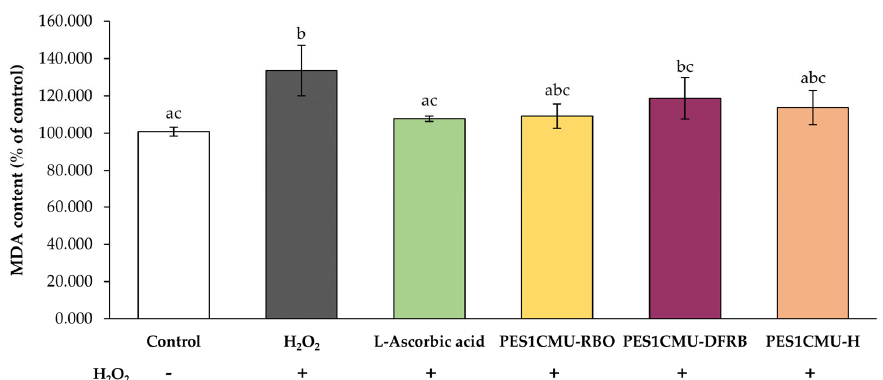
Figure 4. Effects of rice bran oil (PES1CMU − RBO), defatted rice bran extract (PES1CMU − DFRB), and husk extract (PES1CMU − H) of Oryza sativa L. cv. PES1CMU extracts on MDA content in fibro